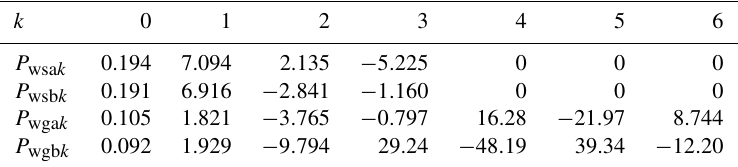
Table 2. Values of P w x a k and P w x b k in Eq. (16).